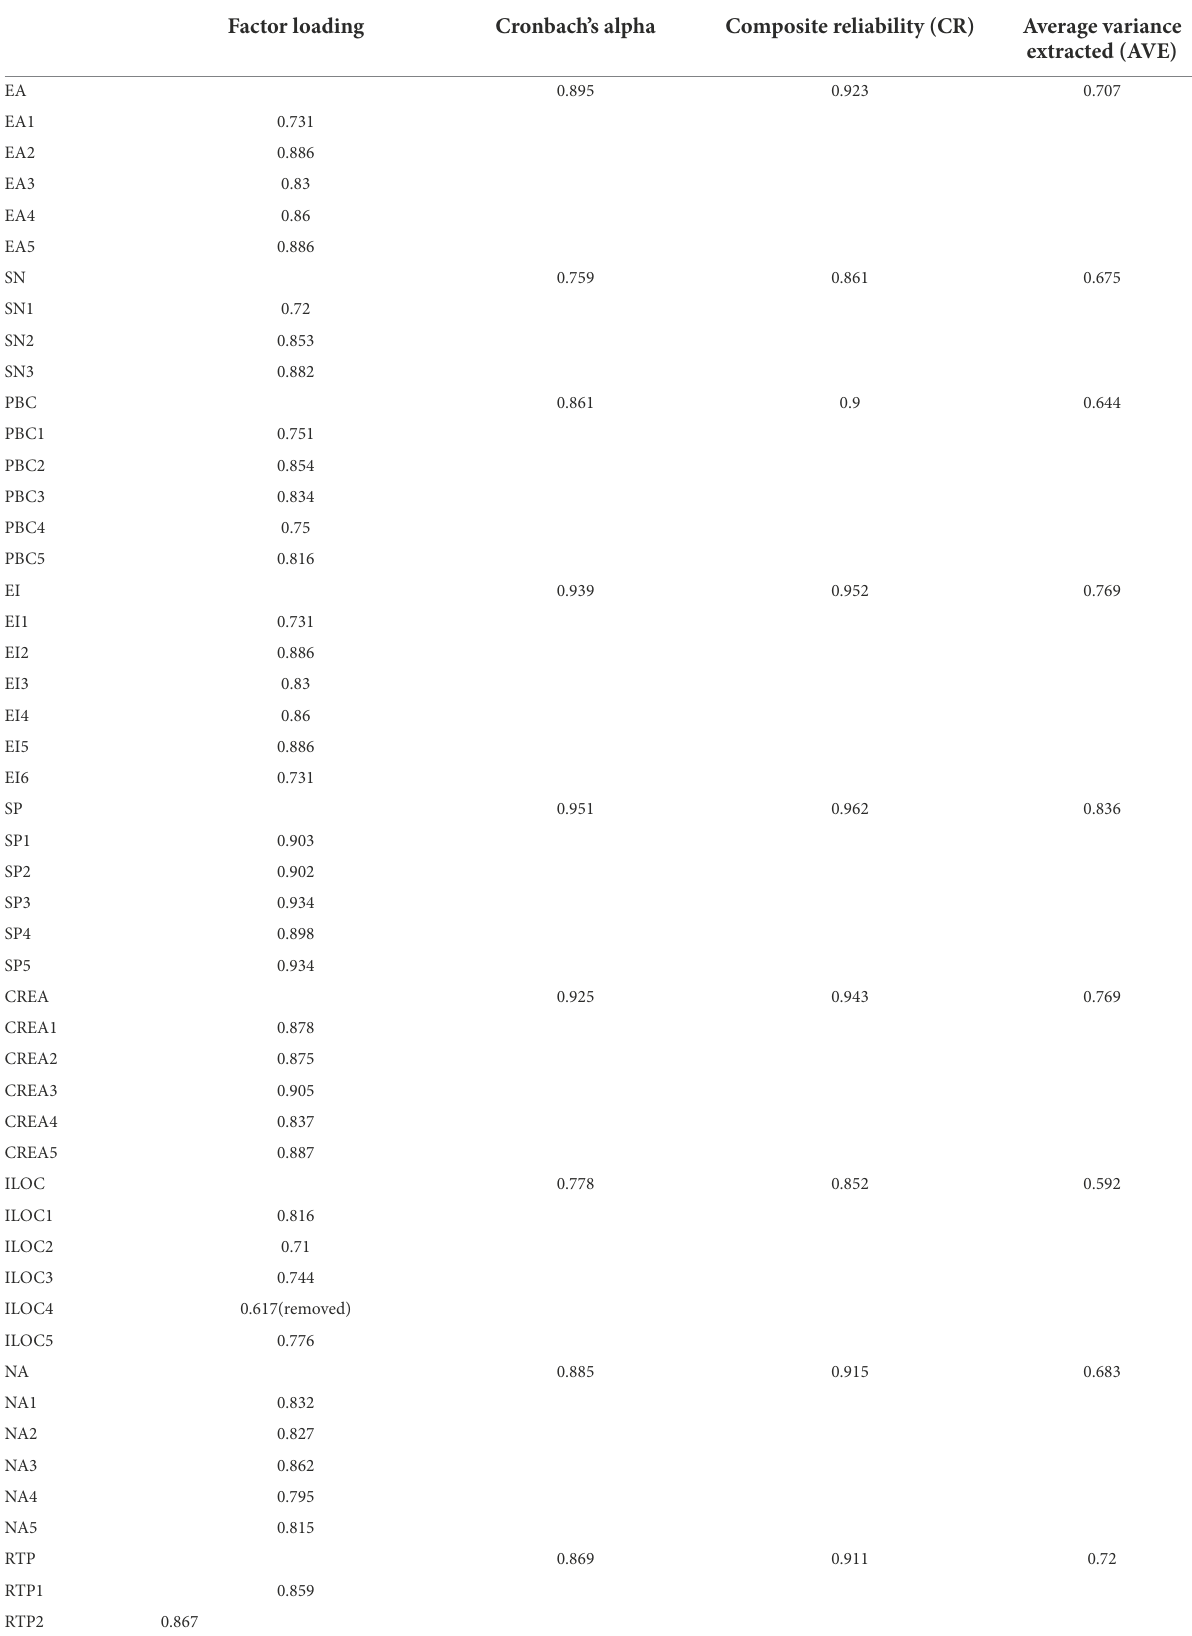
TABLE 4 Construct reliability and